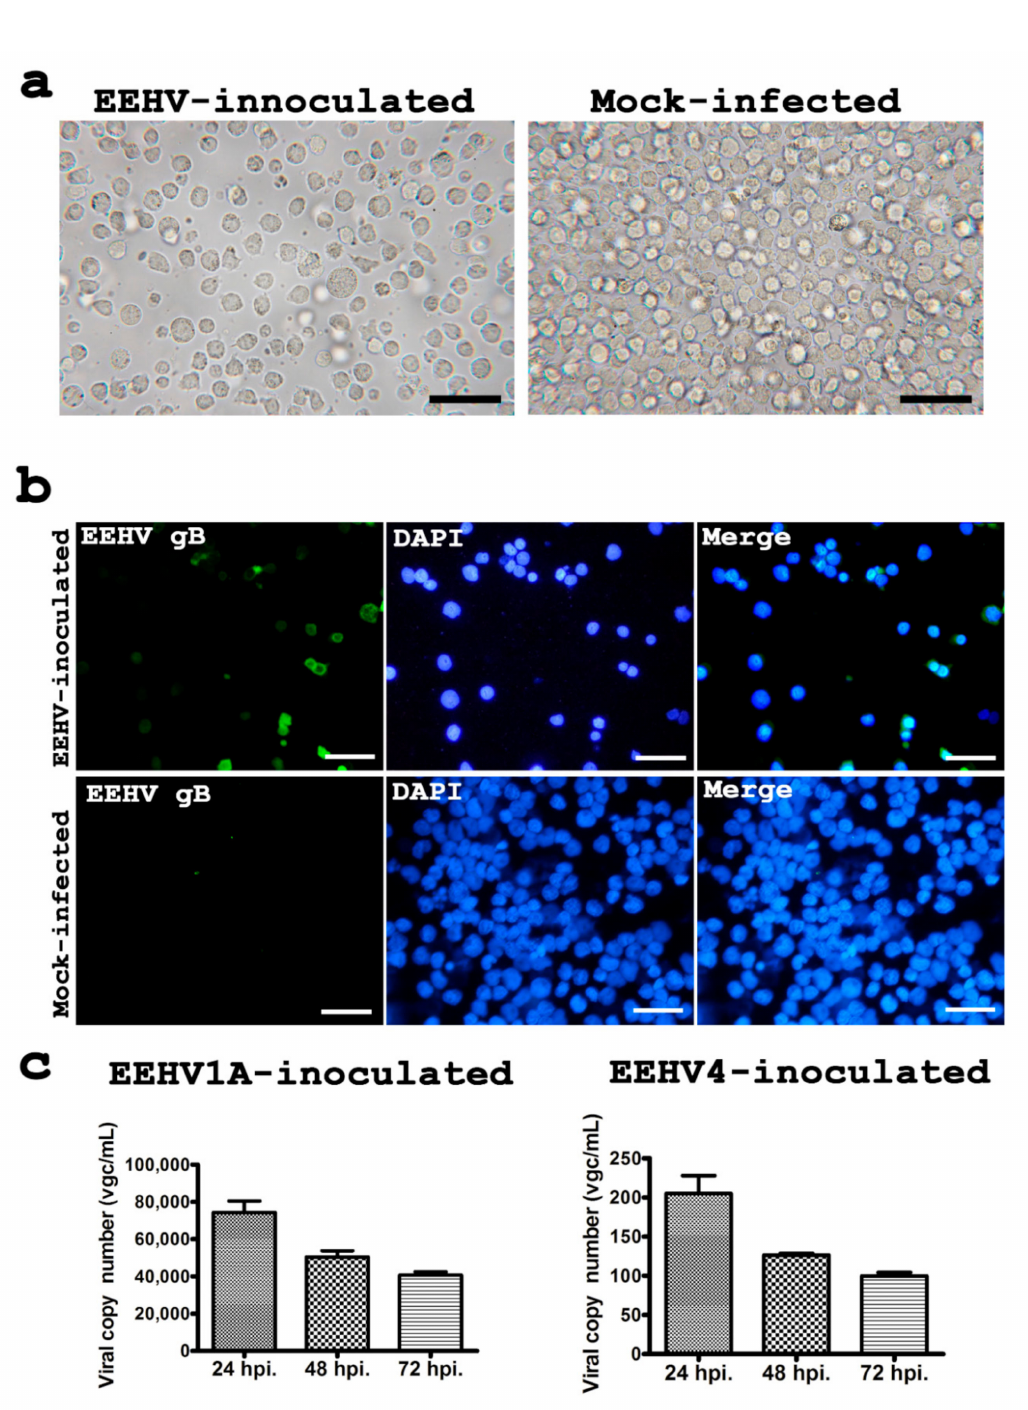
Figure 2. Cell morphology, immunolabeling for EEHV gB and determination of EEHV terminase genes in the U937 cells after inoculation with EEHV. At 72 hpi, although no cytological changes were observed in the U937 cells ( a ), immunolabeling for the EEHV gB was shown to be positive by immunofluorescence in the EEHV-inoculated group ( b ). Quantitative PCR presented as viral genome copies (vgc / mL) of the U937 cell culture supernatant at 24, 48 and 72 hpi indicated that there was a reduction of EEHV in both the EEHV1A-inoculated and EEHV4-inoculated cells ( c ). Scale bars in ( a ) ~200 µ m, in ( b ) ~300 µ